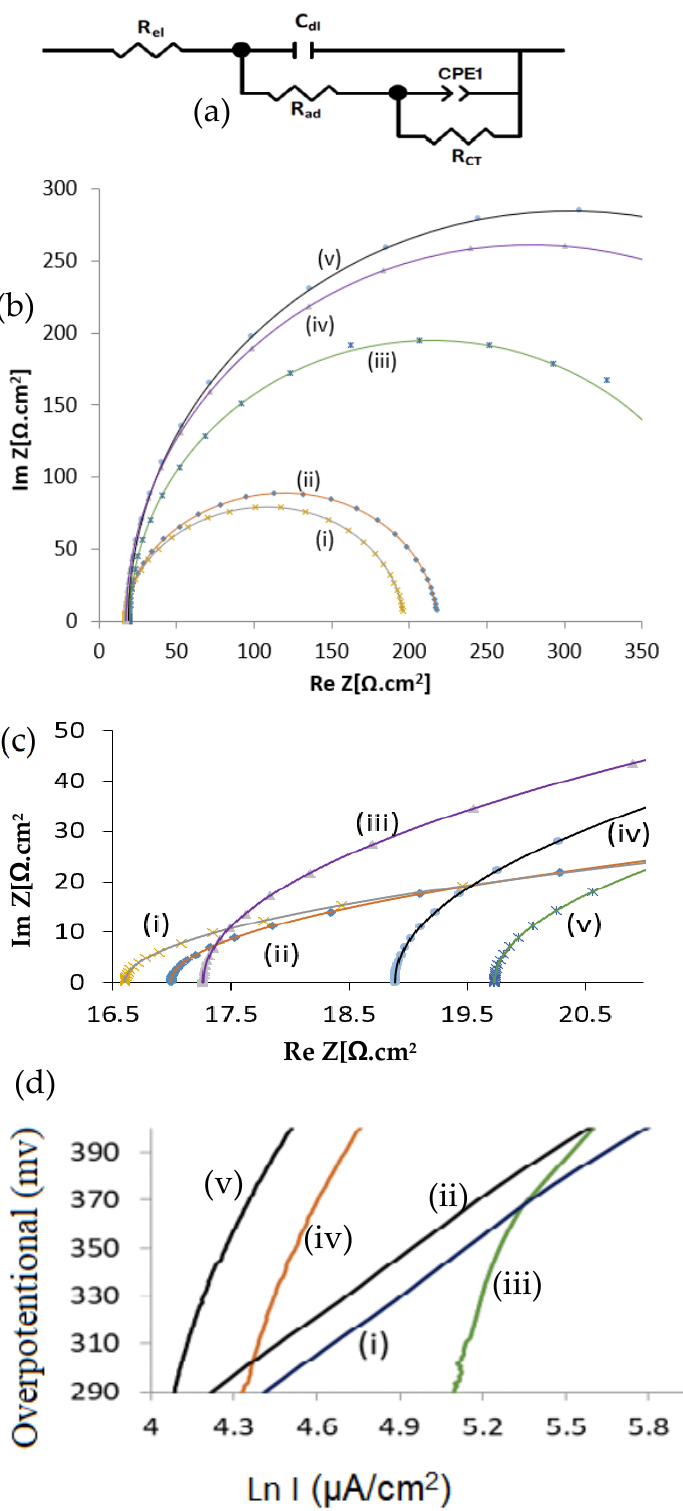
Figure 7. Electrochemical Impedance Spectroscopy: ( a ) equivalent circuit, ( b ) full Nyquist plot, ( c ) Nyquist plot of high frequency region only, ( d ) Tafel plots, of: (i) PEDOT/nano Co 3 O 4 /rGO illuminated with light, (ii) PEDOT/nano Co 3 O 4 /rGO without light illumination, (iii) Pt control, (iv) PEDOT control illuminated with light, and (v) PEDOT control without light. The individual points in ( b , c ) display measured data, while the solid lines display data modelled using the equivalent circuit depicted in ( a